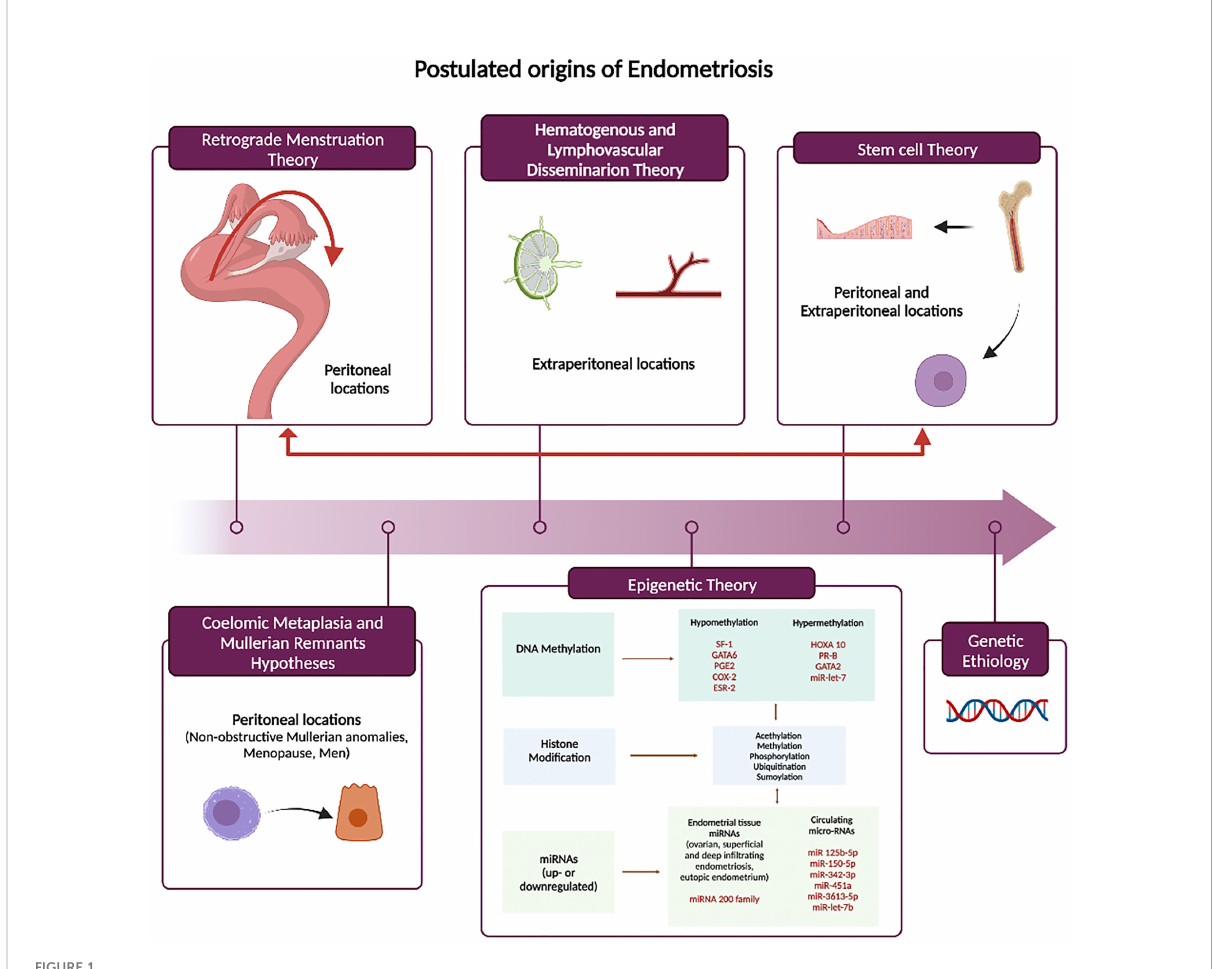
FIGURE 1 Theories of Endometriosis Pathogenesis. SF-1, steroidogenic factor 1;GATA6, GATA binding protein 6;PGE2, Prostaglandin E 2 ;COX2, cyclooxygenase-2;ESR-2, estrogen receptor alpha; HOXA10, homebox protein A10;PR-B, progesterone receptor isoform B; GATA2, GATA binding protein